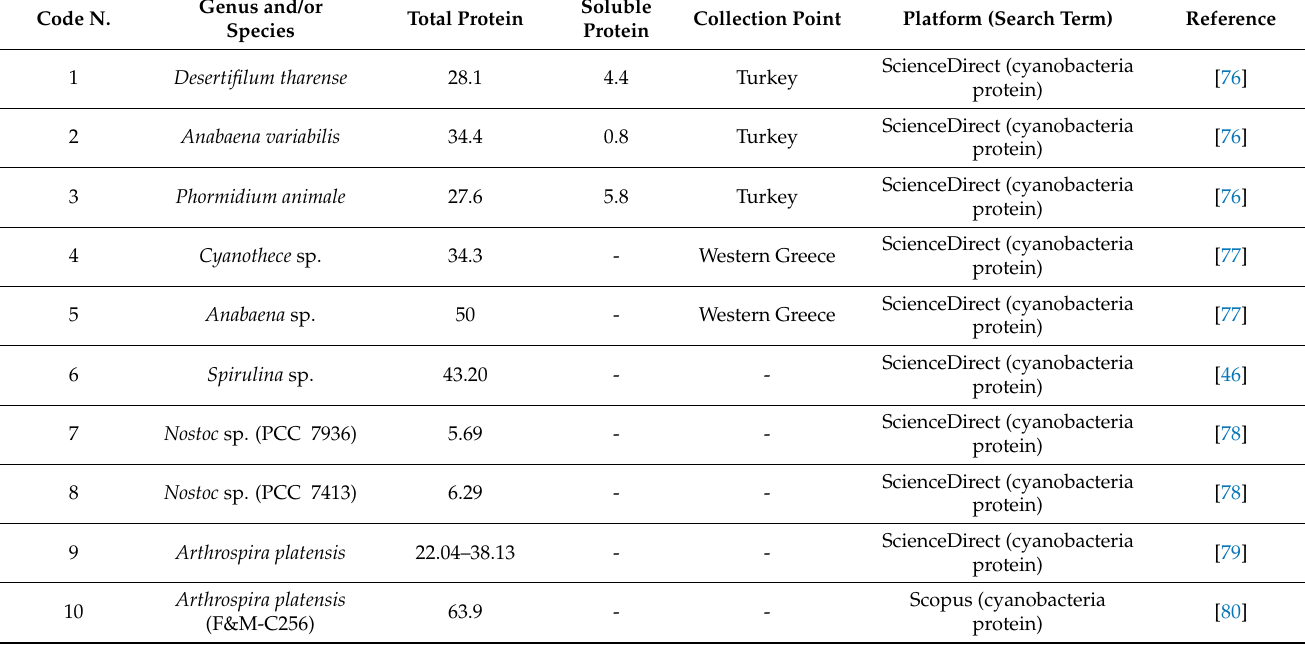
Table 7. Protein content in cyanobacteria selected for this review [41,46,64,76–92] 1 . Code